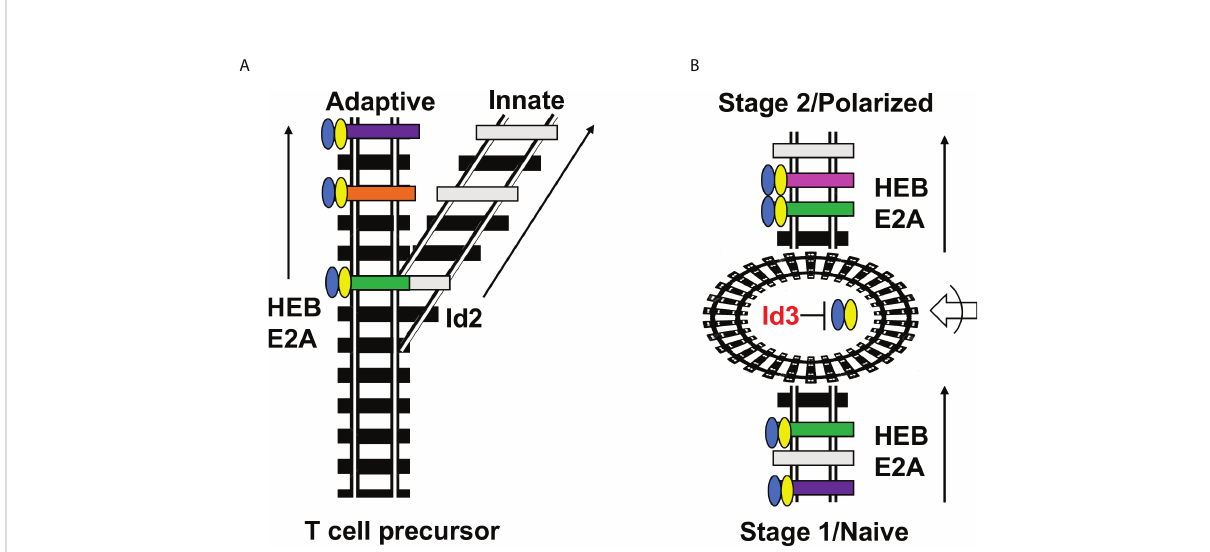
FIGURE 2 Railroad analogy of Id2 versus Id3 outcomes. (A) Id2 acts as a switch that diverts T cell precursors away from the adaptive fate and towards the innate fate by permanently silencing E protein activity and E protein target gene expression. (B) Id3 serves as a way station (roundhouse) that allows changes in accessibility of E protein target genes while E proteins are inactive, followed by E protein engagement with different E protein target genes at the next stage of development. This occurs in both CD4 T cell differentiation (Naïve/Polarized) and multiple stages of thymic differentiation (Stage 1/Stage 2). Blue-Yellow ovals = HEB/E2A. Black railroad ties = completely inaccessible genes; gray railroad ties = accessible genes lacking the proper combination of transcription factors for induction; colored railroad ties = E protein target genes bound by HEB/E2A and undergoing active transcription. Roundabout = Id3-mediated pause in E protein activity during which changes in accessibility of E protein target sites occurs. Arrow with half circle = extracellular signaling inputs that direct which genes undergo changes in chromatin